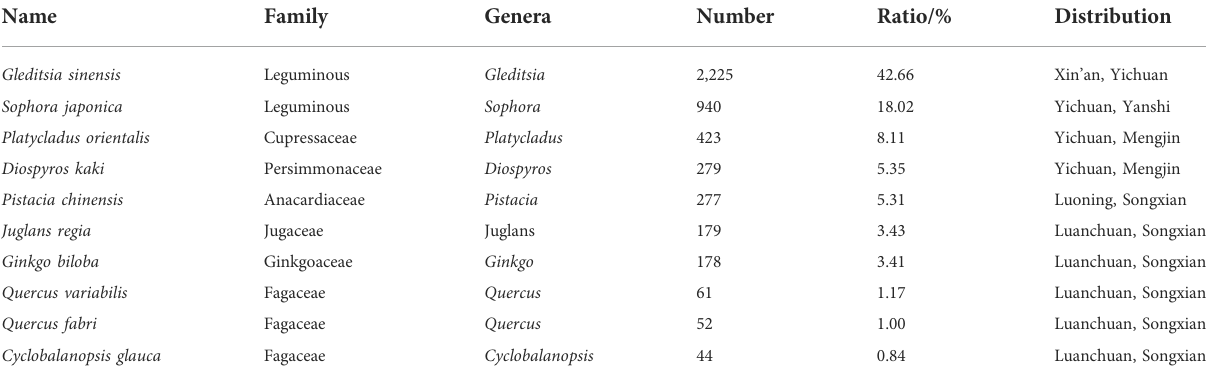
TABLE 1 Statistics of the top 10 heritage tree species in Luoyang.